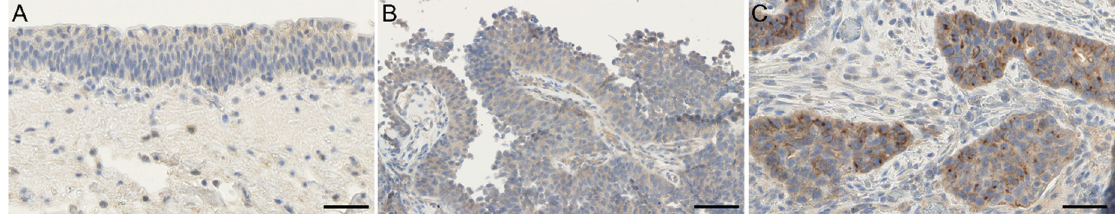
Figure 2. Immunohistochemical staining of SLC35F2 in patient 7. ( A ) Not/weak stained typical urothelium; ( B ) NMIBC, weak stained; ( C ) MIBC, moderate to strong stained. SLC35F2 is weak to moderate and uniformly stained in urothelium and in the majority of NMIBC. Increased staining of SLC35F2 was detected mainly around the nucleus of tumour cells in MIBC compared with NMIBC and typical urothelium. Scale bar = 50 µm.